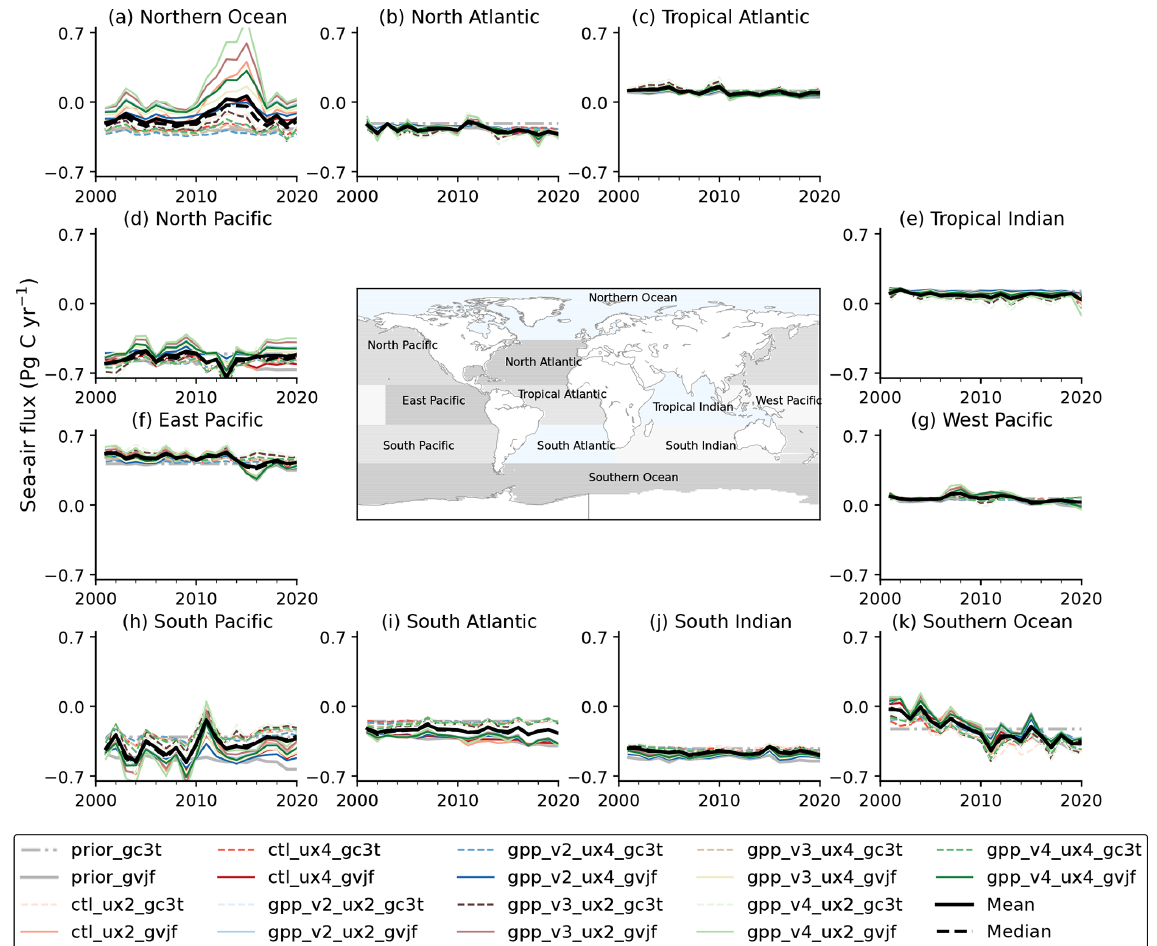
Figure 7. Interannual variation of sea–air CO 2 fluxes derived from 16 sets of inversion. The variations are shown for 11 aggregated regions shown in the map. The negative values are counted as CO 2 removals from the atmosphere, while CO 2 emissions are counted